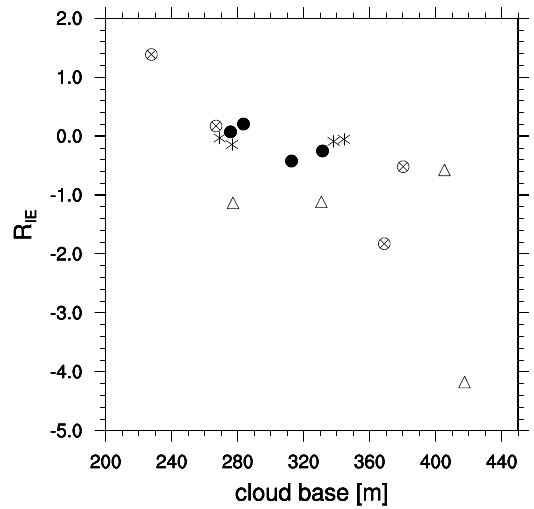
Fig. 16. The mean ratio of second to first indirect effect ( R IE ) for N a from 100 to 200 cm − 3 during nighttime (4–7h, black filled circle) and daytime (12–15h, circle with cross inside), and from 200 to 1000 cm − 3 during nighttime (asterisk) and daytime (triangle).